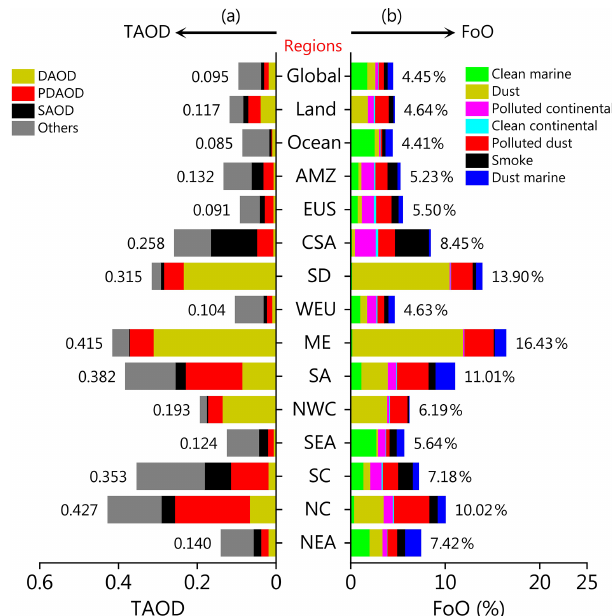
Figure 8. Multi-year regional averages of the (a) AODs and (b) fre- quency of occurrence (FoO) for different types of aerosols over the globe, land, ocean, and 12 ROIs. The number next to each bar rep- resents the regional total FoO or total